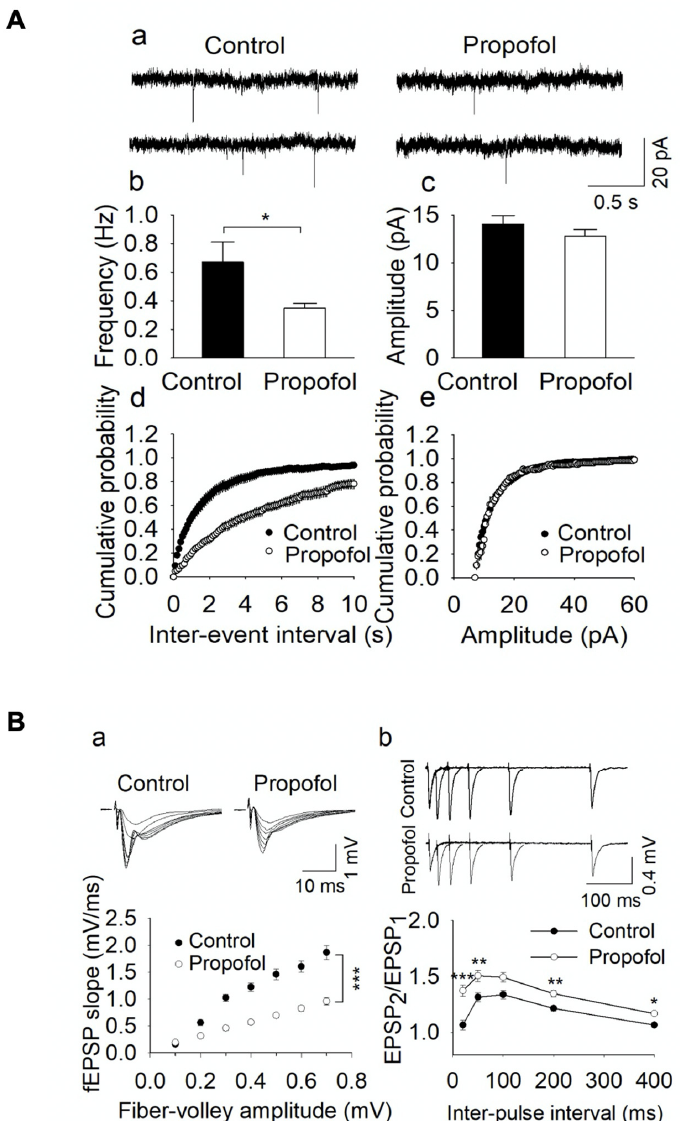
Figure 3. Developmental propofol exposure caused the decreased excitation/glutamate release in P60 mouse hippocampal neurons. ( A ) P7 propofol-exposed P60 mouse hippocampal CA1 pyramidal neurons displayed the reduction of excitation. ( a ) Examples of miniature excitatory postsynaptic current (mEPSC) traces from control and propofol groups. ( b ) The mean frequency of mEPSCs was decreased in propofol group (n = 13–14, t 25 =2.356, * p < 0.05). ( c ) Propofol exposure did not alter the mean amplitude of mEPSCs ( t 25 = 1.126, p = 0.271). ( d , e ) Propofol resulted in a right shift of the cumulative distribution of inter-event intervals (n = 13–14; * p < 0.001). However, there was no dif- ference of the cumulative amplitude distribution between control and propofol groups. Data from all events were averaged and pooled. ( B ) The field excitatory postsynaptic potential (fEPSP) slopes (( b ), n = 7; * p < 0.05, ** p < 0.01, *** p < 0.001).